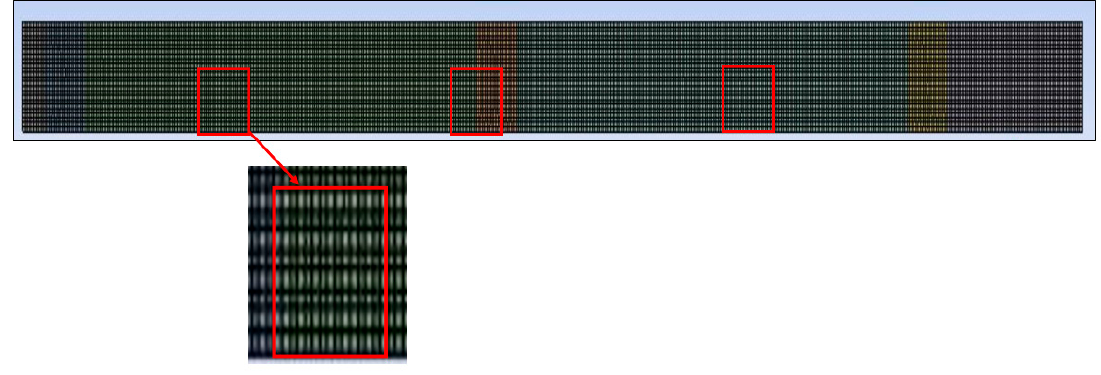
Figure 3. Quadrilateral mesh of 88 mm metal, foam block, solar air heater.